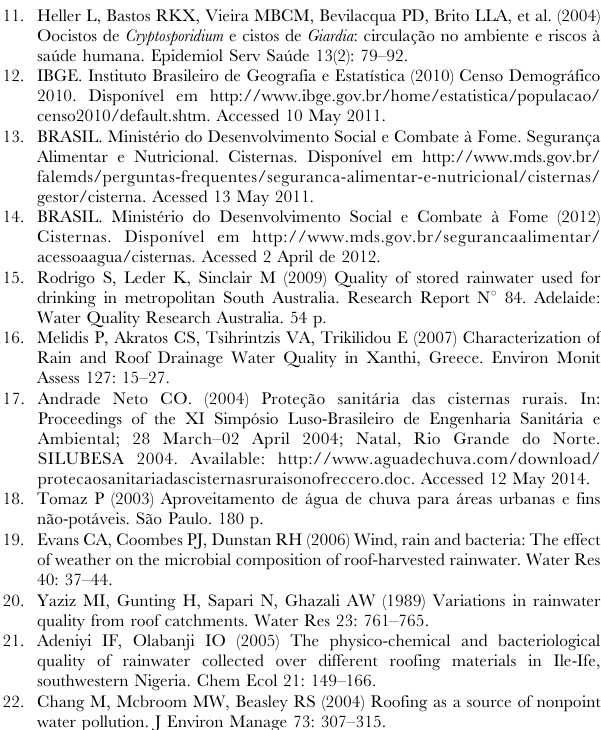
Table S1 Initial model for the analysis of G. duodenalis infection in children living in Northeast region of Minas Gerais State, Brazil, 2009-2010, according to socioeconomic, sanitary and pregnancy aspects and using marginal logistic regression